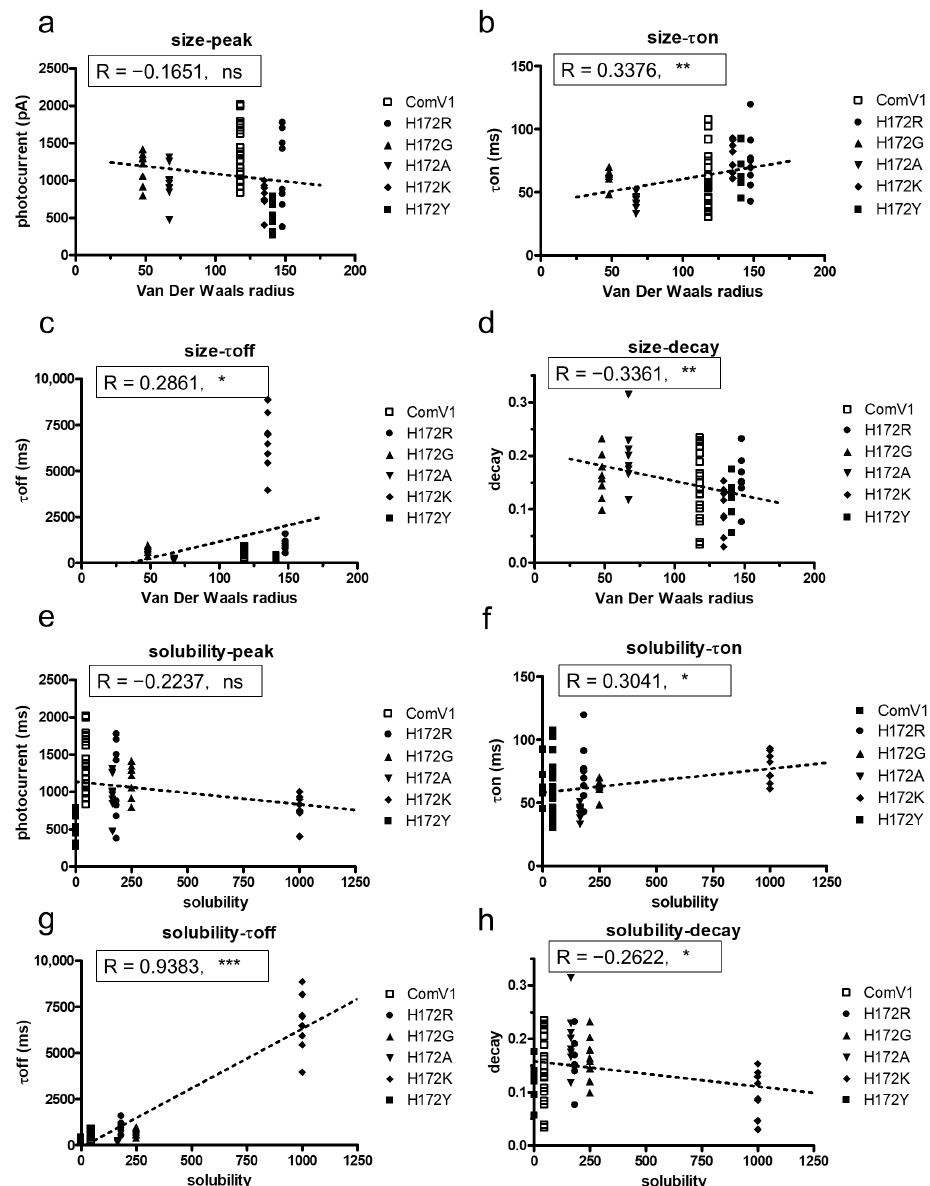
Figure 3. Correlation between properties of the 172nd amino acid and channel function of ComV1 and mutants. ( a – d ) Correlation between the size of the 172nd amino acid residue and channel properties, peak currents ( a ), τ on ( b ), τ off ( c ), and decay ( d ) at 505 nm. ( e – h ) Correlation between the solubility of the 172nd amino acid residue and channel properties, peak current ( e ), τ on ( f ), τ off ( g ), and decay ( h ). All data were analyzed with Pearson correlation coefficient (* p < 0.05, ** p < 0.01, *** p < 0.001, ns: not significant).